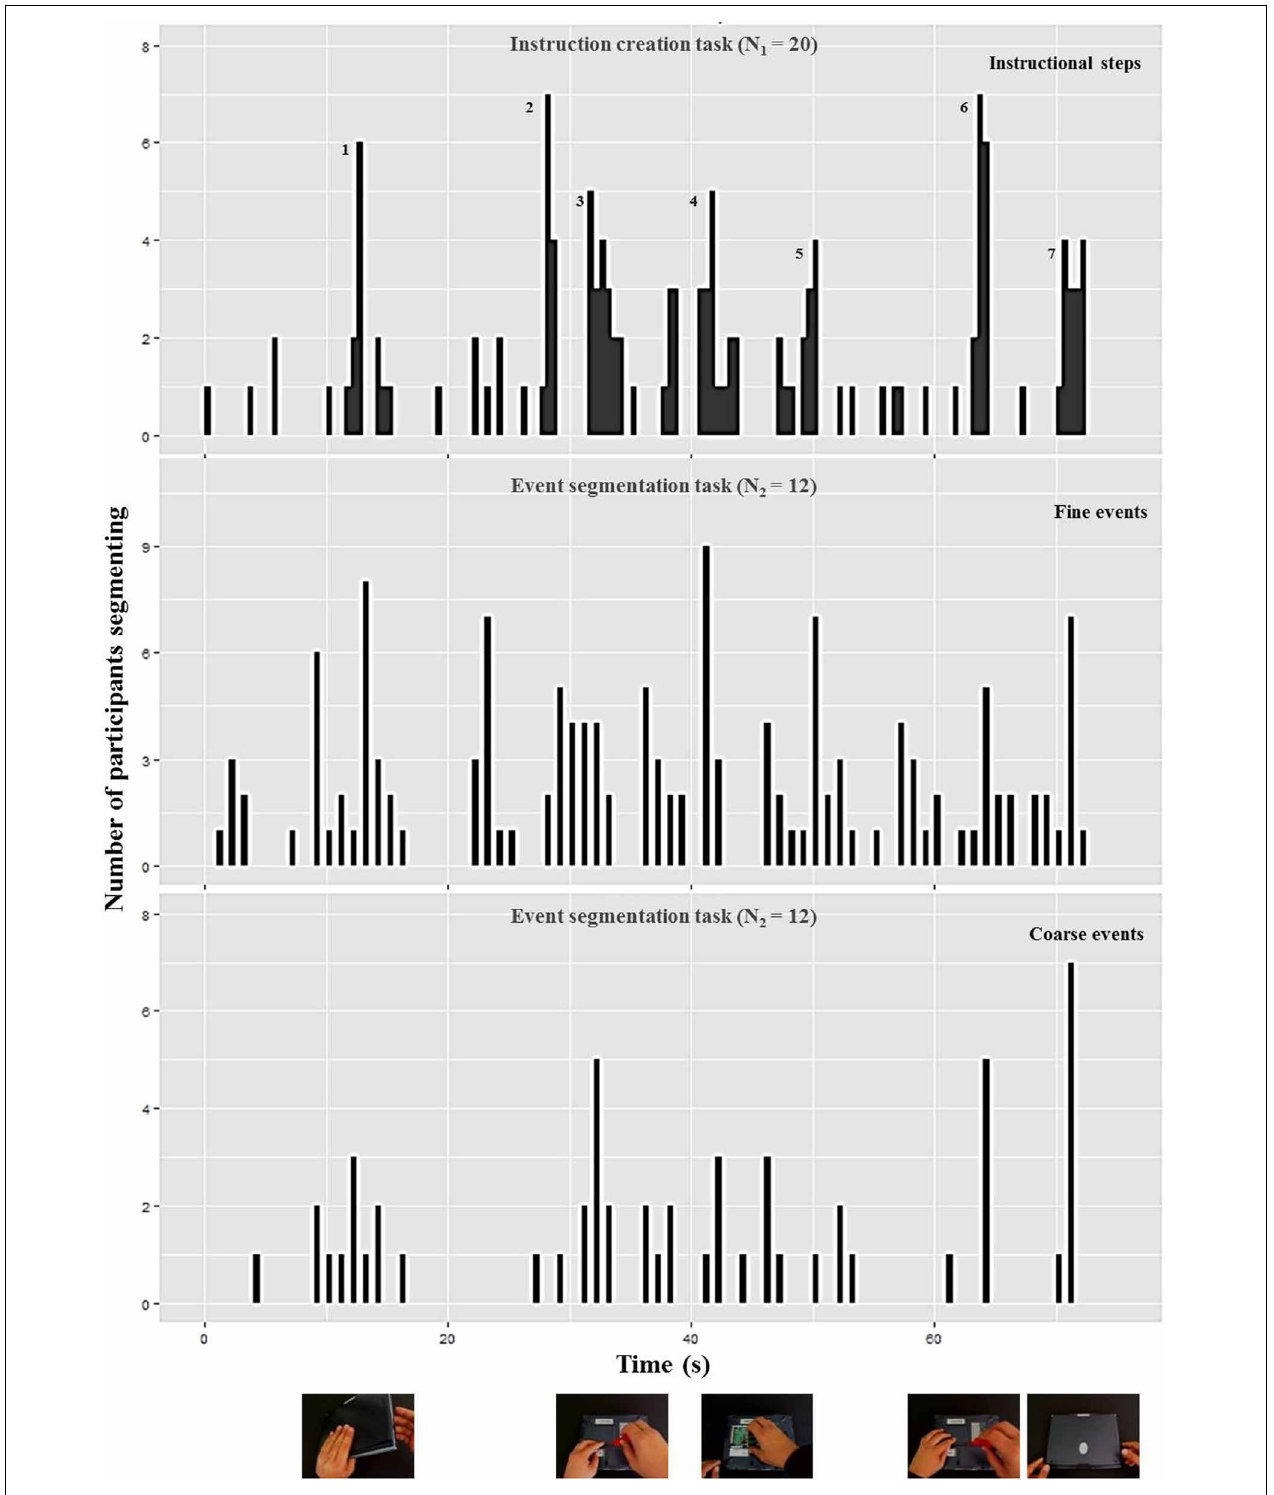
FIGURE 5 | Number of participants who identified the end point of a step (“instruction creation task,” upper diagram), a fine event boundary (“event segmentation task,” middle diagram), and a coarse event boundary (“event segmentation task,” lower diagram) during each 1-s interval of the notebook scenario [adapted from Zacks et al.